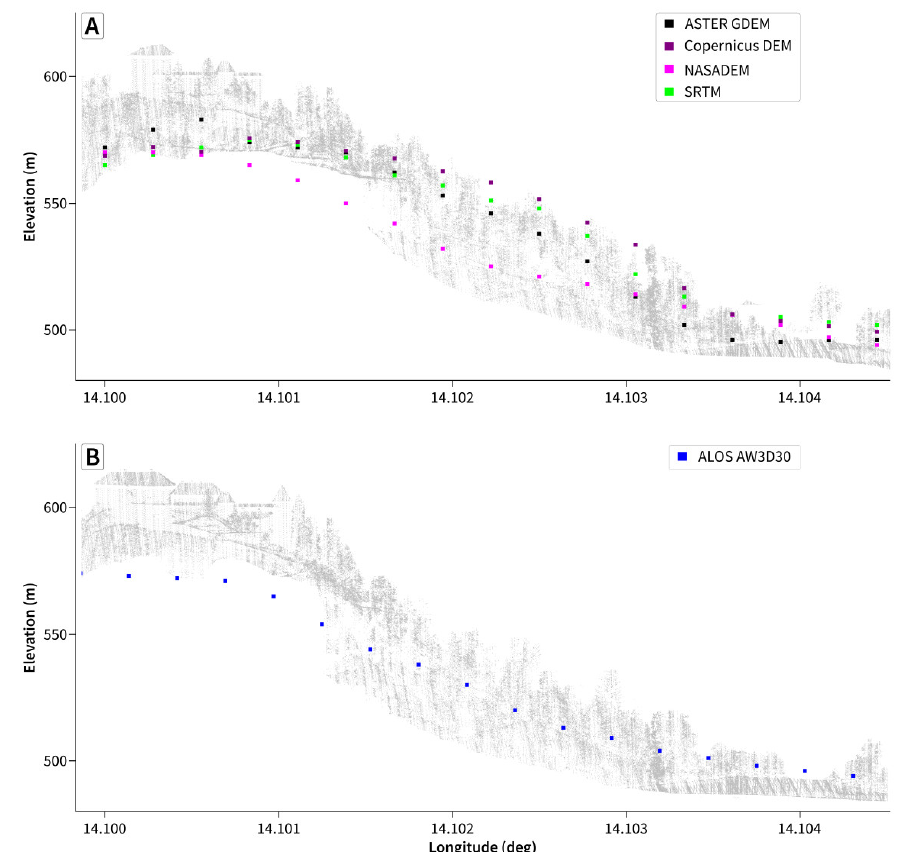
Figure 8. Profiles along a one arc second east-west slice through lidar point cloud in Bled, Slovenia and the points from ( A ) 4 global DEMs with common pixel representation, and ( B ) ALOS which has half pixel offsets compared to the others. As shown in Figure 6C, the area sampled by each ALOS pixel covers 1 ⁄ 4 of the area of each of 4 pixels in the other DEMs. In this profile, half of the lidar points in the two profiles are the same, but the other half are to the north or south of the common